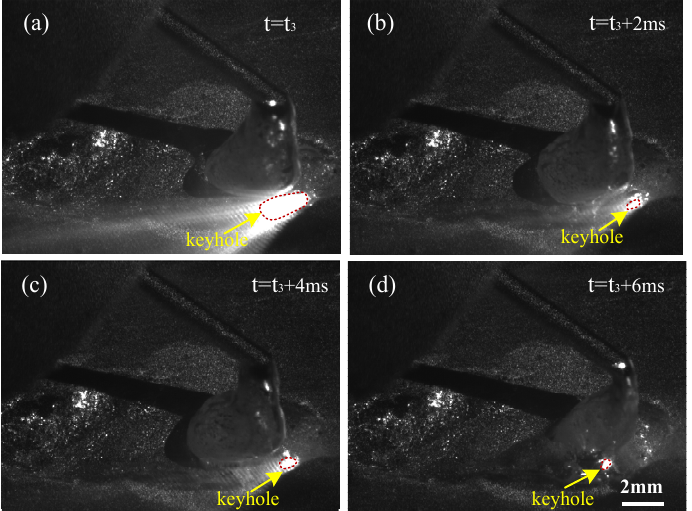
Figure 5. Experimentally observed keyhole fluctuation during the droplet transfer stage. ( a ) t = t 3 ; ( b ) t = t 3 + 2 ms; ( c ) t = t 3 + 4 ms; ( d ) t = t 3 + 6 ms.